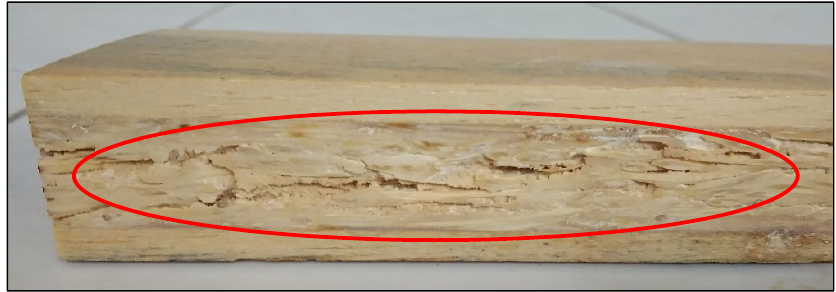
Figure 5. Failure of laminated compreg composites pressed with 30% CR.